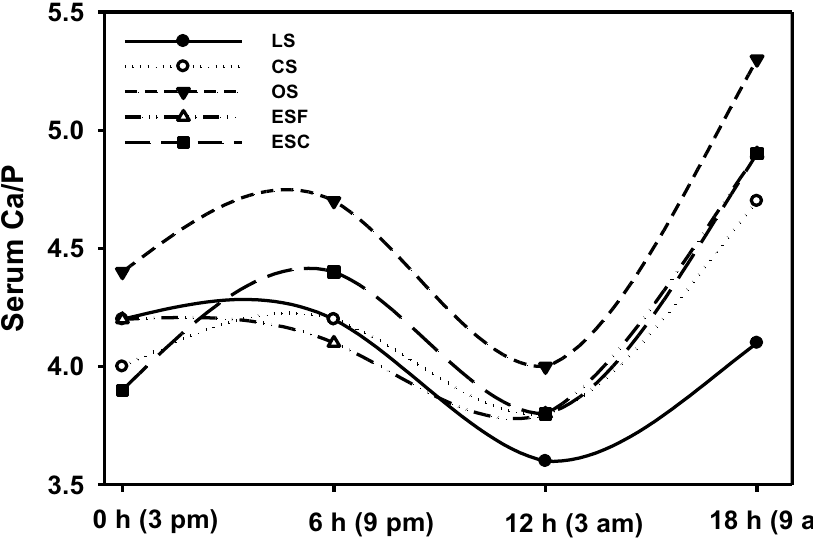
Figure 1. Effects of different dietary Ca sources on the serum Ca and P ratio during light and dark periods (18 h) in laying hens at 80 week of age. LS limestone (< 2 and 2–4 mm mixed in 3:7); CS cockle shell (1–4 mm); OS oyster shell (3–16 mm); ESF eggshell fine particles (< 1 mm); ESC eggshell coarse particles (3–5 mm). Results are the means of 4 hens per treatment.